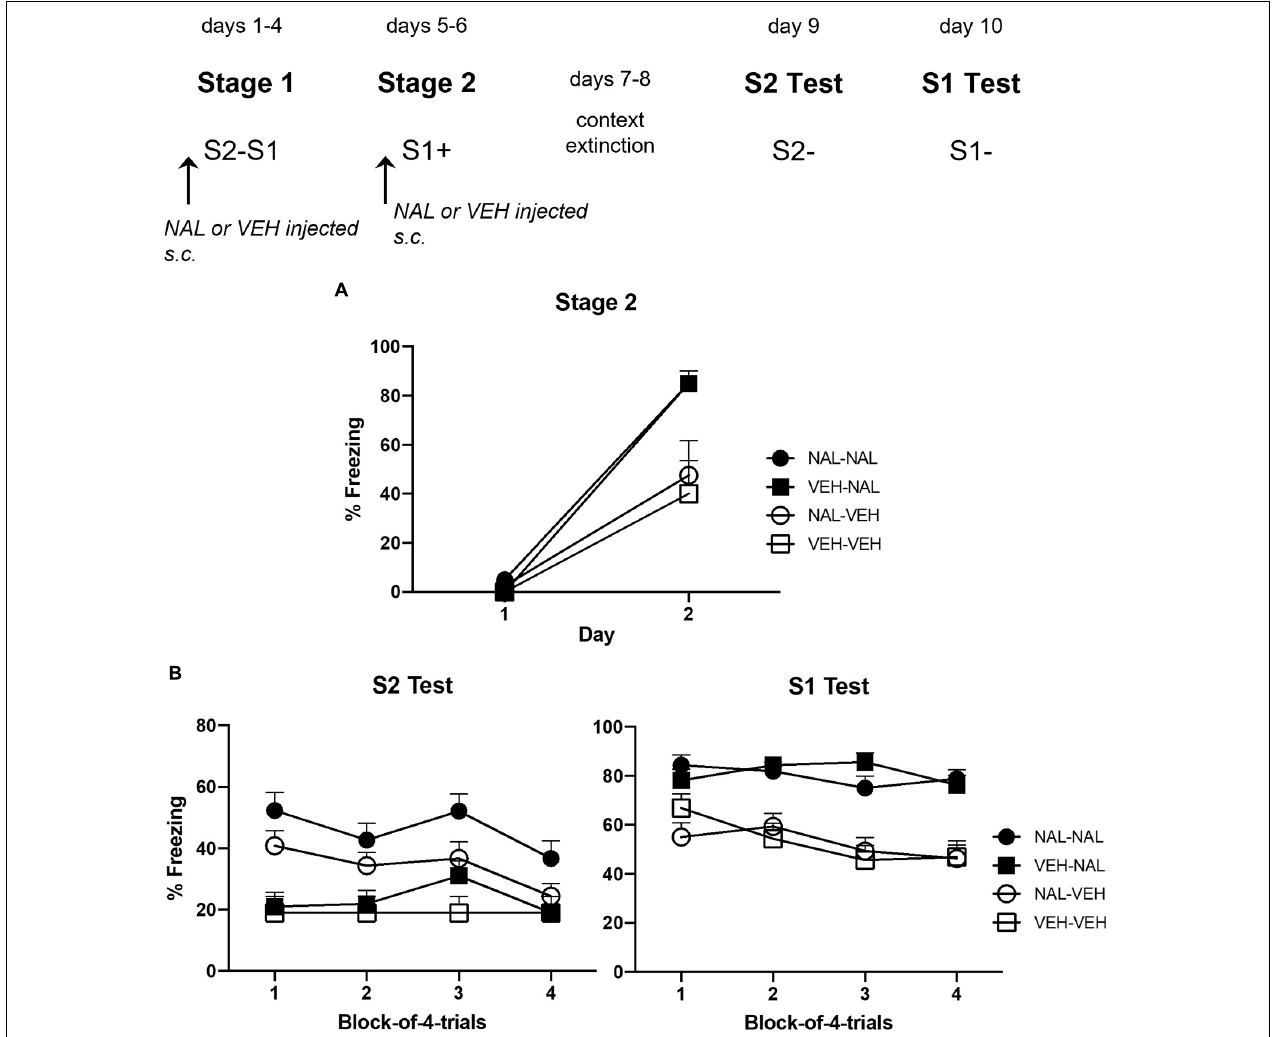
FIGURE 4 | Results of Experiment 2b showing that naloxone enhances the acquisition of sensory preconditioning and first-order conditioned fear. (A) Shows the mean (+ SEM) levels of freezing to S1 across its pairings with shock in stage 2. (B) Shows the mean (+ SEM) levels of freezing during the final drug-free tests across blocks of four S2 alone trials (left panel) and four S1 alone trials (right panel). The numbers of rats in each group were: Group NAL-NAL, n = 8; Group VEH-NAL, n = 8; Group NAL-VEH, n = 8; and Group VEH-VEH, n =